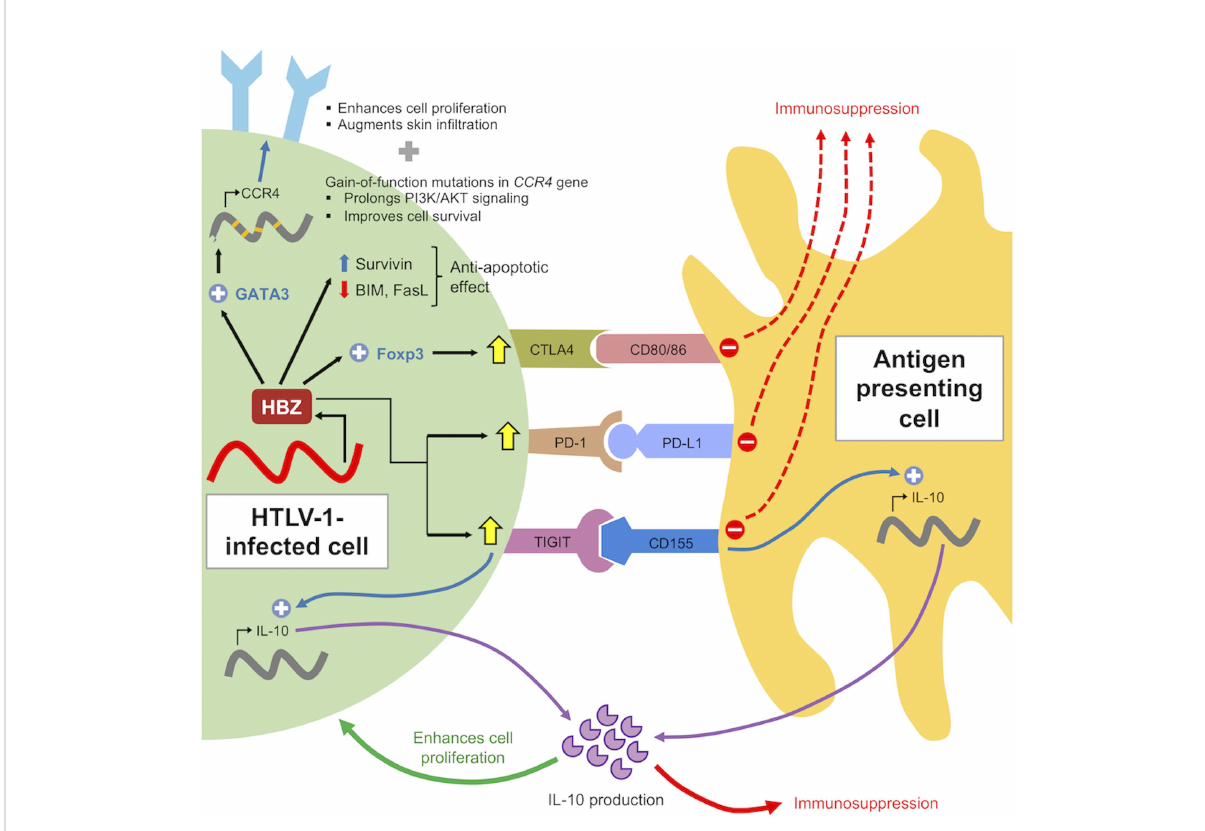
FIGURE 3 Role of HBZ in immune evasion of infected cells. HBZ induces expression of co-inhibitory molecules to suppress immune activation and confers anti-apoptotic properties by altering expression pattern of pro- and anti-apoptotic proteins. HBZ also induces IL-10 expression in infected cells and antigen presenting cells through TIGIT. IL-10 acts to suppress host immune response as well as enhancing cellular proliferation of infected cells through modulation of STAT signaling by HBZ (not